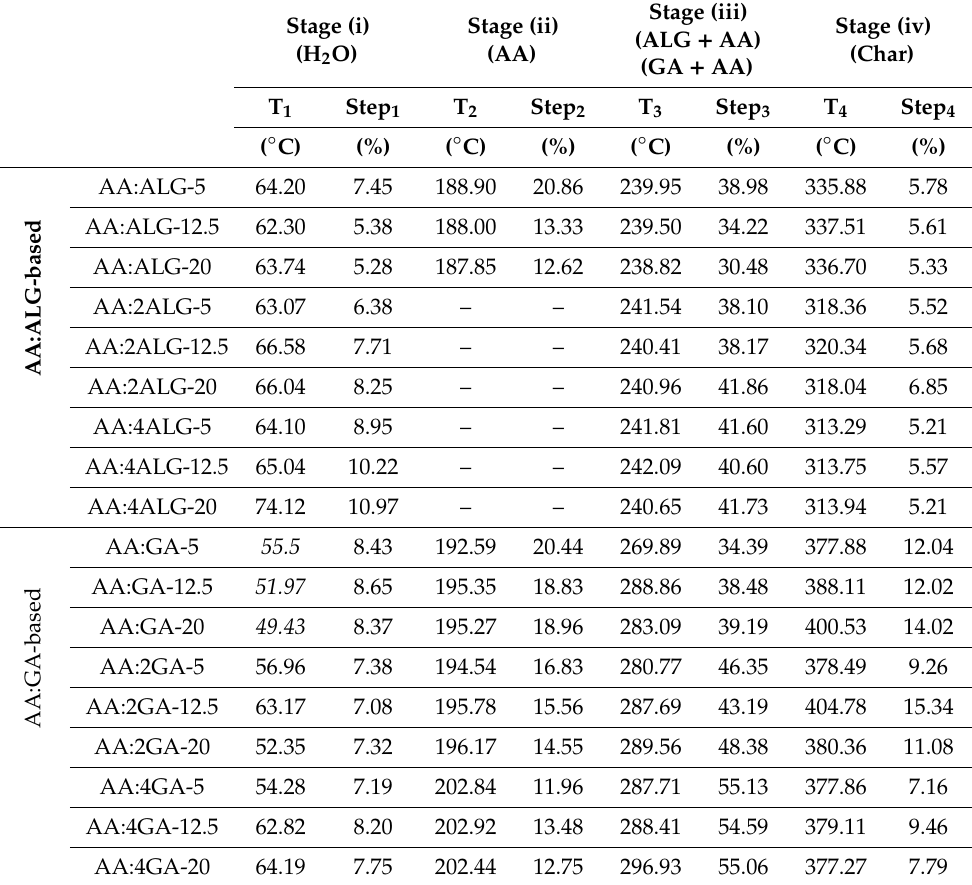
Table 5. Peak temperatures and mass loss during the thermogravimetric analyses for the AA:ALG and AA:GA-based